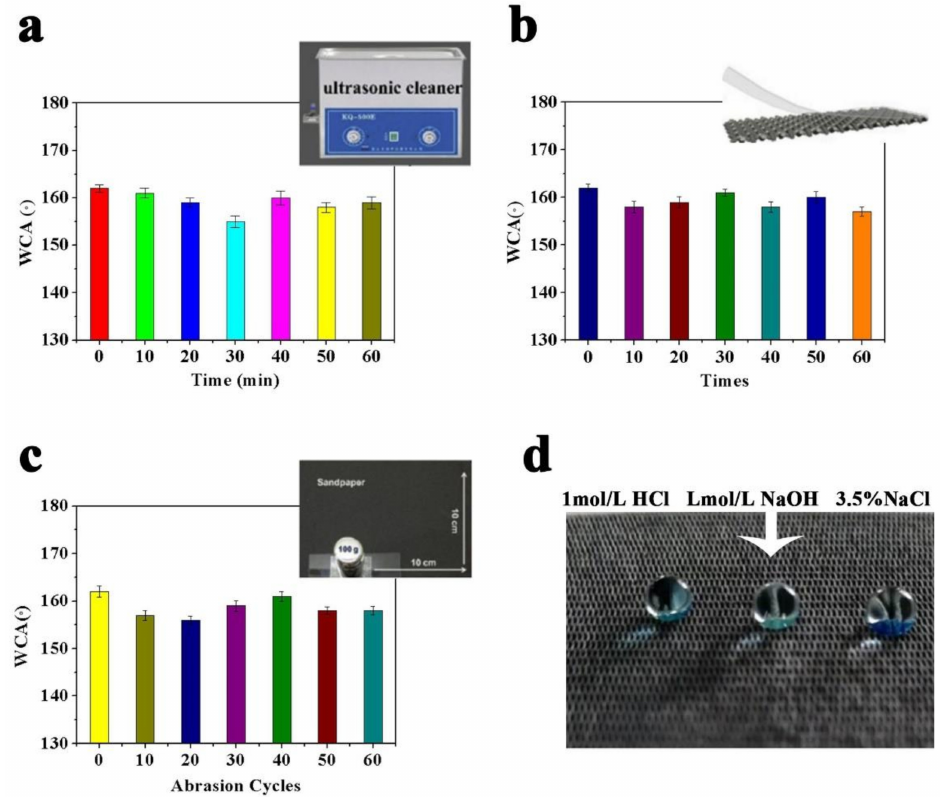
Figure 4. Durability tests for the modified mesh ( a – c ), and chemical stability ( d